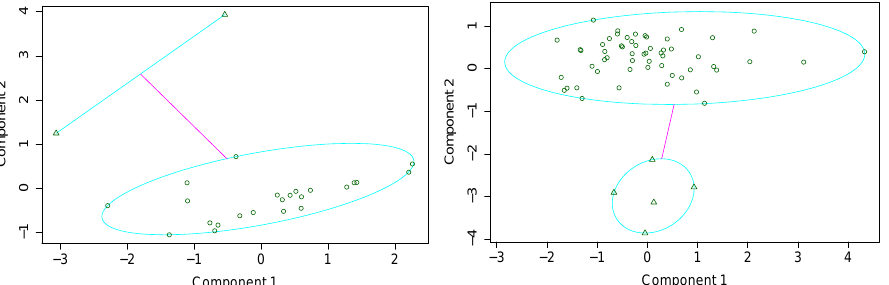
Figure 14. Same as Figure 10. The left panel shows PAM clustering with the three parameters being τ lag,i , log SSFR , and host galaxy offset. The outliers are GRBs 031203A and 060505A. The right panel shows PAM clustering with the three parameters being τ lag,i , T 50,i , and log t burst . The outliers are GRBs 060607A, 080721A, 090926A, 091127A, and 130408A. ) × log L + ( 684 + 118 ) × Without the two outliers, one finds τ lag,i = ( − 1091 + 152 pk,52 − 164 − 129 ) . Considering L ∼ E log E iso,52 + ( 703 + 37 iso,52 / T 90 , this relationship is actually pk,52 − 85